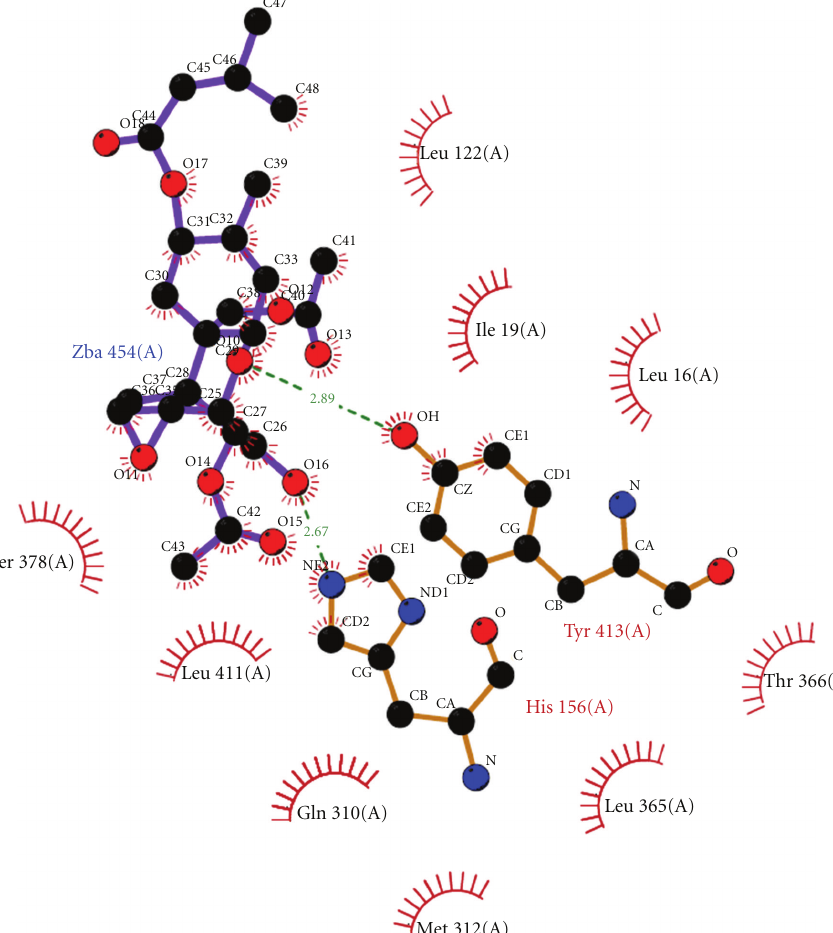
Figure 3: Ligplot image of interaction between ZBA (T2 mycotoxin) with trichothecene 3-O-acetyltransferase. Green dotted lines are hydrogen bond interactions and red semicircles are the hydrophobic